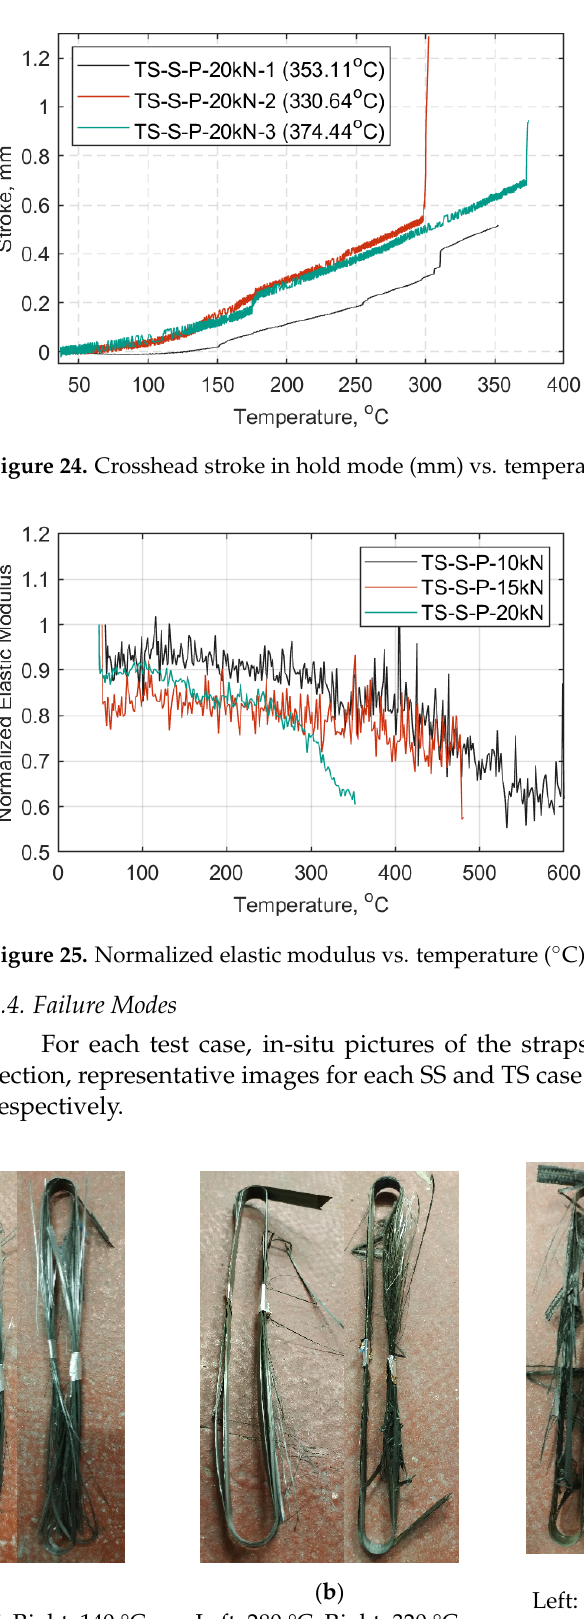
Figure 23. Crosshead stroke in hold mode (mm) vs. temperature (°C): All TS cases at 15 kN.